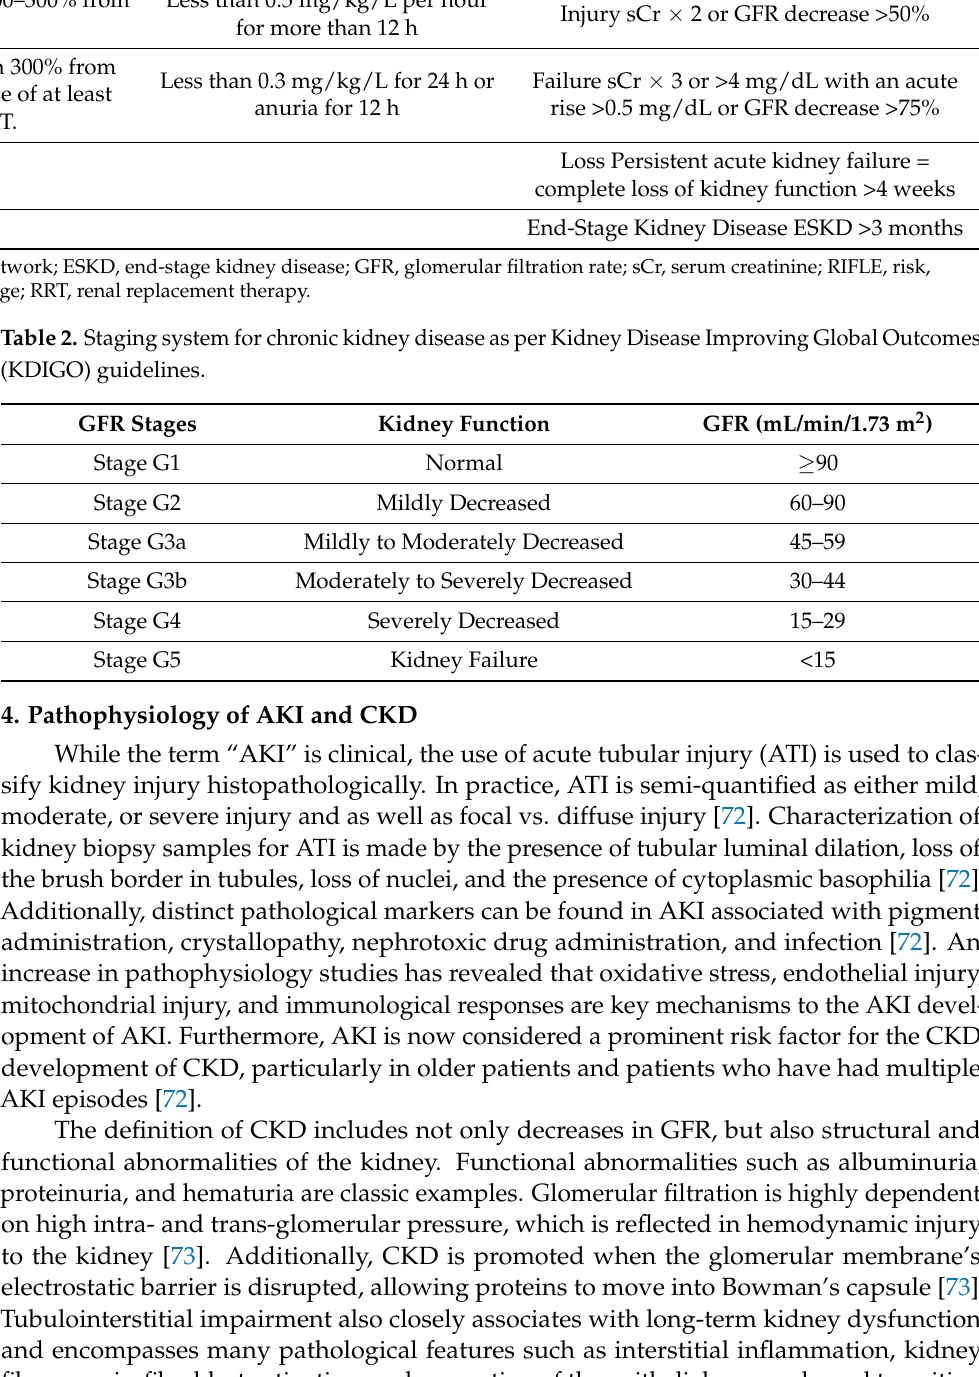
Table 1. AKIN vs. RIFLE classification for kidney injury based on serum creatinine (sCr) and/or urinary outputs (UO). AKIN UO (Common to Both) RIFLE Stage 1 Increase of ≥ 0.3 mg/dl or increase in Less than 0.5 mg/kg/L per hour Risk Increase in sCr × 1.5 or GFR decrease more than or equal to 150–200% from for more than 6 h >25% baseline. Stage 2 Increase to more than 200–300% from Less than 0.5 mg/kg/L per hour Injury sCr × 2 or GFR decrease >50% baseline. for more than 12 h Stage 3 Increased to more than 300% from baseline with an acute increase of at least 0.5 mg/dL or on RRT.